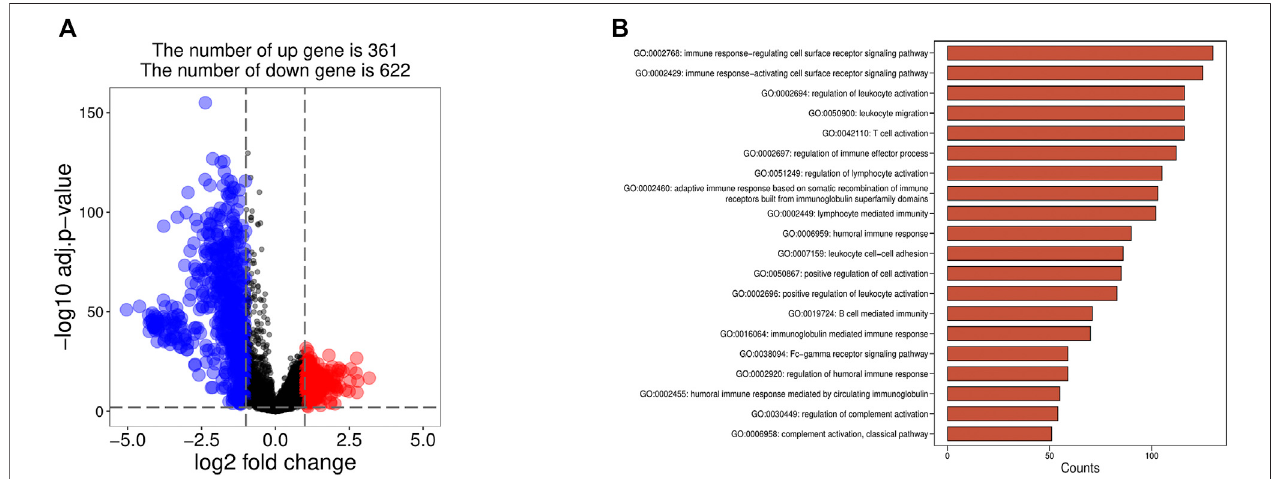
FIGURE 2 | (A) The DEGs visualization was screened by limma. (B) GO enrichment analysis of the